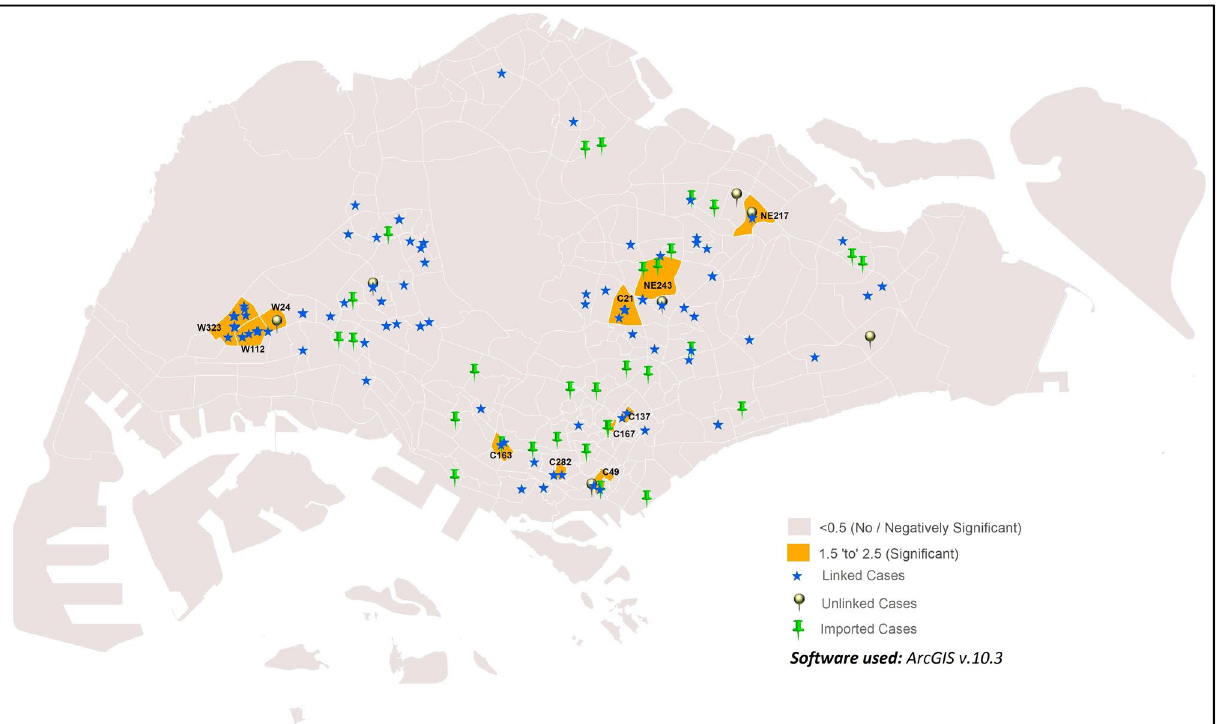
Figure 2. GWR of COVID-19 cases vs. temperature in the early phase of COVID-19